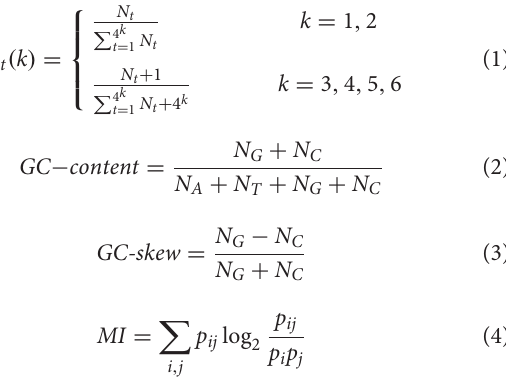
MNase-seq signal, and Top2 binding signal. These features are calculated in the following